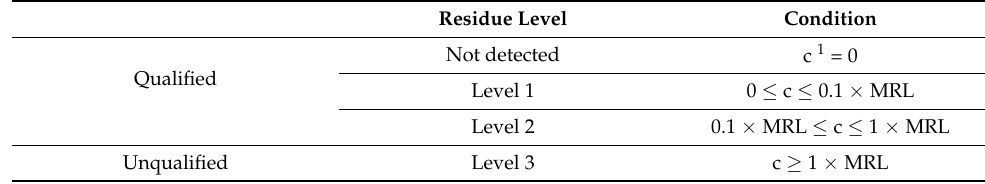
Table 2. Rule of residue level